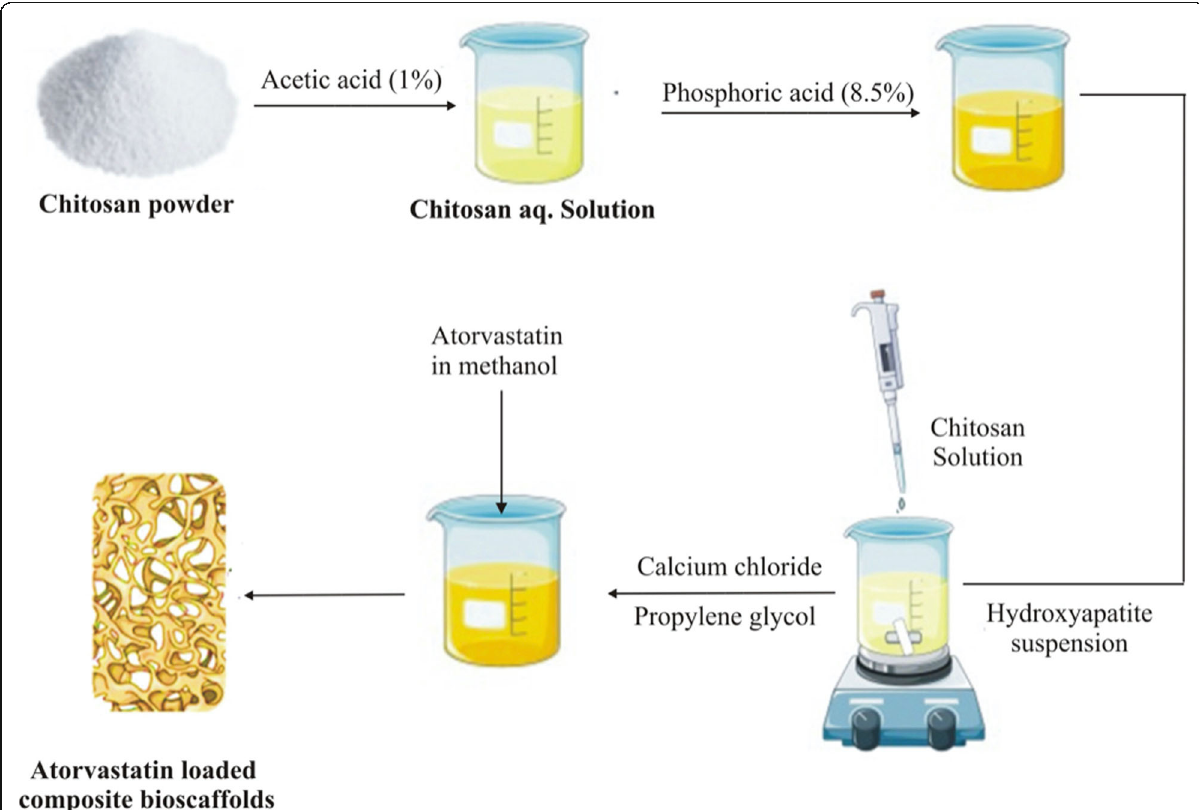
Fig. 1 Method of preparation of atorvastatin-loaded composite